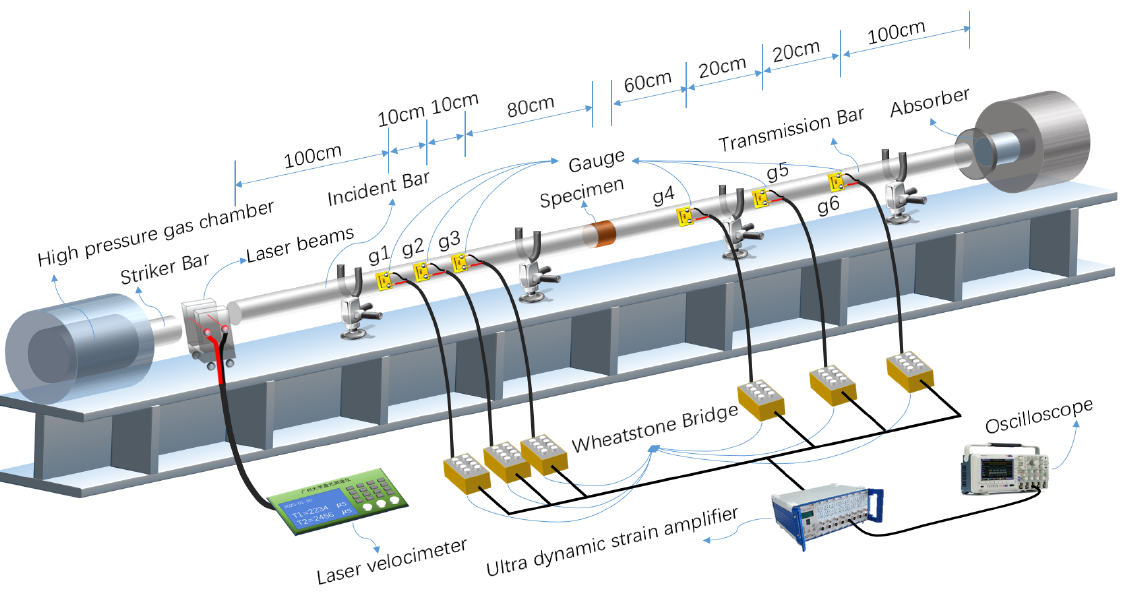
Figure 3. SHPB experimental setup.